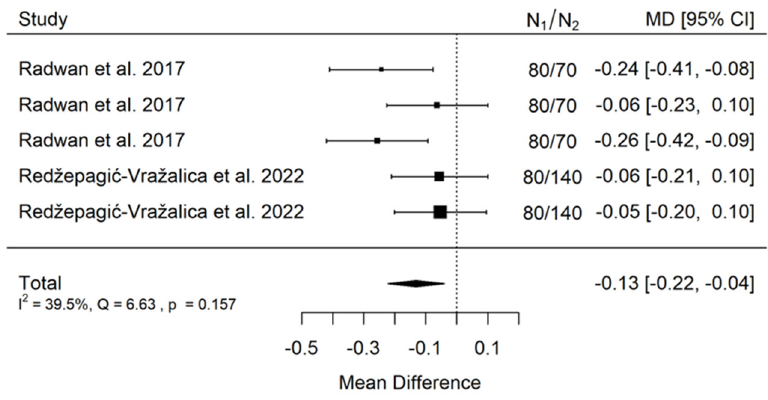
Figure 4. Forest plot for evalutaion of thread pitch dimension infulence on pull-out strentght in animal bone model studies [38,44].